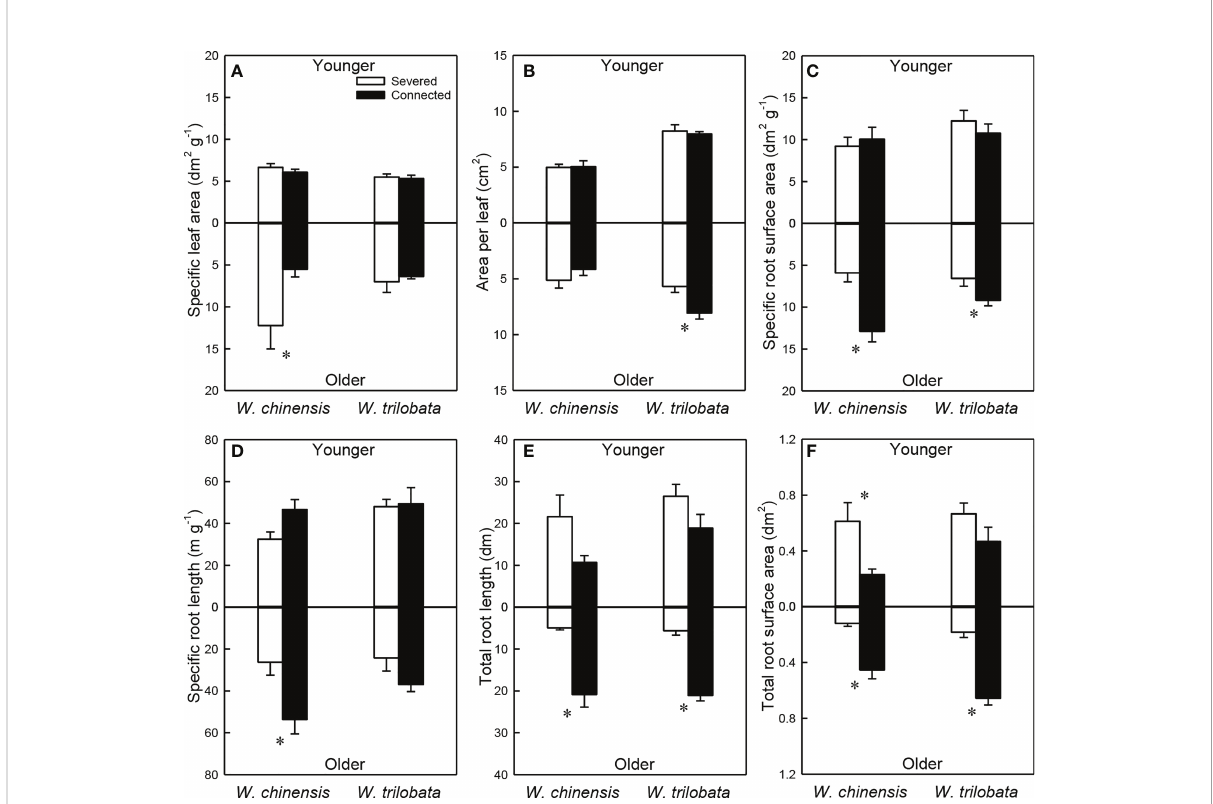
FIGURE 3 Speci fi c leaf area (A) , area per leaf (B) , speci fi c root surface area (C) , speci fi c root length (D) , total root length (E) and total root surface area (F) of the younger ramet (above the x-axis) and the older ramet (below the x-axis) of the invasive plant Wedelia trilobata and the native plant W. chinensis . Values are means ± SE. Symbols (* P < 0.05) indicate the signi fi cant differences between the severed and connected ramets within a